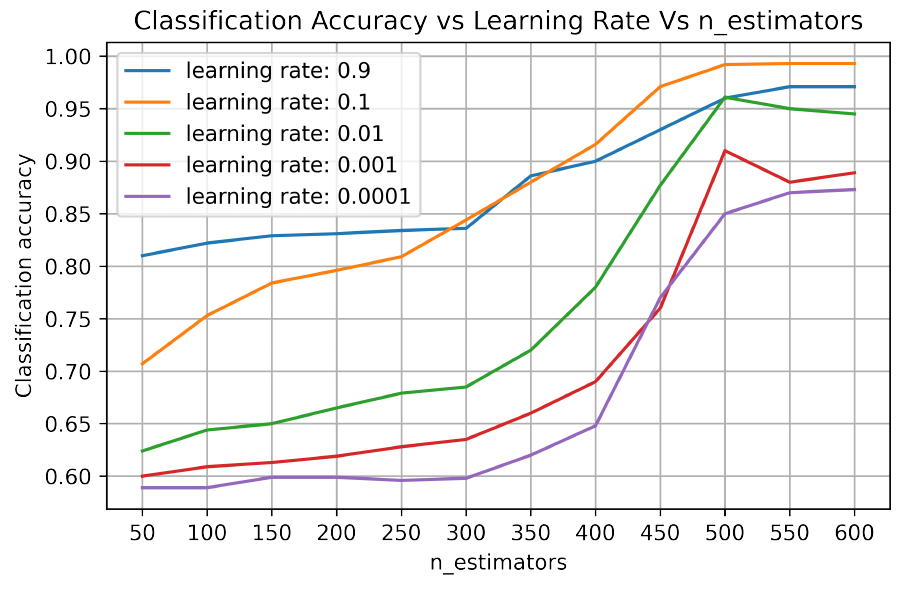
Figure 5. Classification accuracy vs. learning rate vs. n_estimators. Table 6. Effect of hyperparameter tuning on localization performance. [Note] lr: learning_rate,